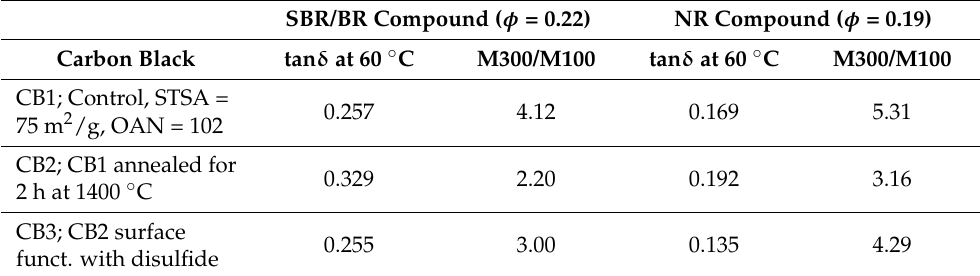
Table 7. Disulfide Functionalization of CB to Counter Reinforcement Loss from Heat Treatment.